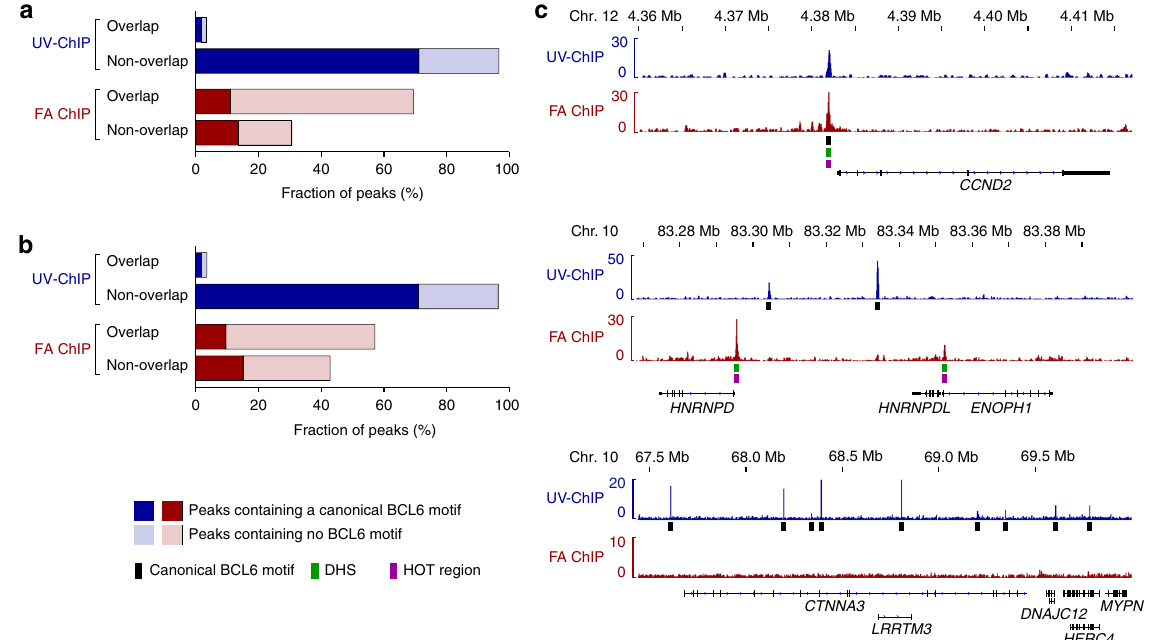
Fig. 3 UV-ChIP-seq reveals preferential BCL6 binding in less accessible chromatin regions. The fraction of BCL6 peaks (%) overlapping or non-overlapping. a DNaseI Hypersensitive Sites (DHSs) in human DLBCL cells and b Highly Occupied Target (HOT) regions in human B cells detected by UV-ChIP-seq (blue) and FA ChIP-seq (red) are shown. The proportion of peaks containing a canonical BCL6 motif ( q -value 0.1) is indicated (dark-colored). c Examples of BCL6 ChIP-seq binding pro fi les at different genomic loci. (Upper Panel) BCL6 binding within the promoter region of the known target gene CCND2 . UV- ChIP-seq (blue track) reveals speci fi c enrichment within an accessible chromatin region (DHS/HOT region) in the CCND2 promoter region overlapping a canonical BCL6 motif. This binding site was also detected by FA ChIP-seq (red track). (Middle Panel) Example of differential BCL6 binding. BCL6 binding pro fi les show enrichment at different locations within the HNRNPD human genomic loci. BCL6 binding sites detected by UV-ChIP-seq overlap canonical BCL6 motifs. FA ChIP-seq identi fi ed BCL6 binding within DHSs and HOT regions to non-canonical DNA sequence motifs. (Lower Panel) Pro fi ling of BCL6 binding within a region of late replicating heterochromatin. UV-ChIP-seq detected several binding sites containing canonical BCL6 motifs within the heterochromatic region at chr.10q21.3, which were not identi fi ed by FA ChIP-seq. Read density pro fi les are shown as fold enrichment track generated by ChIP over input DNA pileup signal with the corresponding scales as indicated. Genomic coordinates and human RefSeq annotations (GRCh37/hg19) are shown. Black boxes indicate canonical BCL6 motif appearance ( q -value 0.1). Peaks overlapping DHSs (green boxes) and HOT regions (purple boxes)